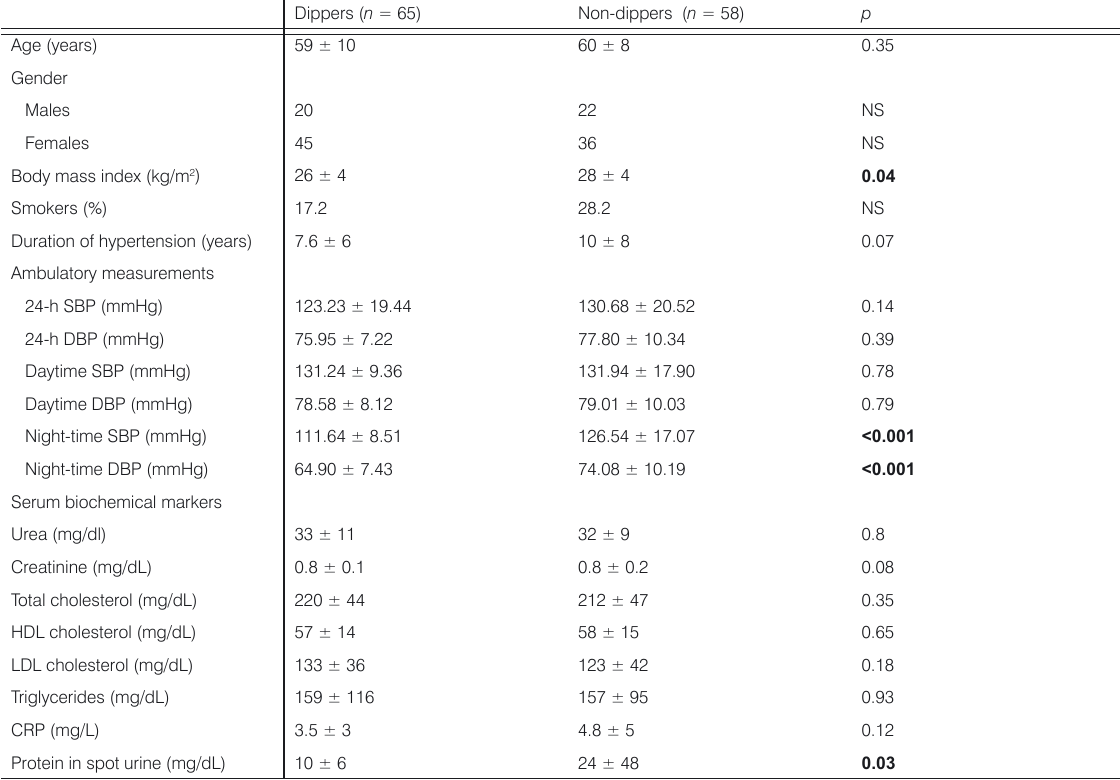
Table 1. Clinical and laboratory characteristics in dippers and